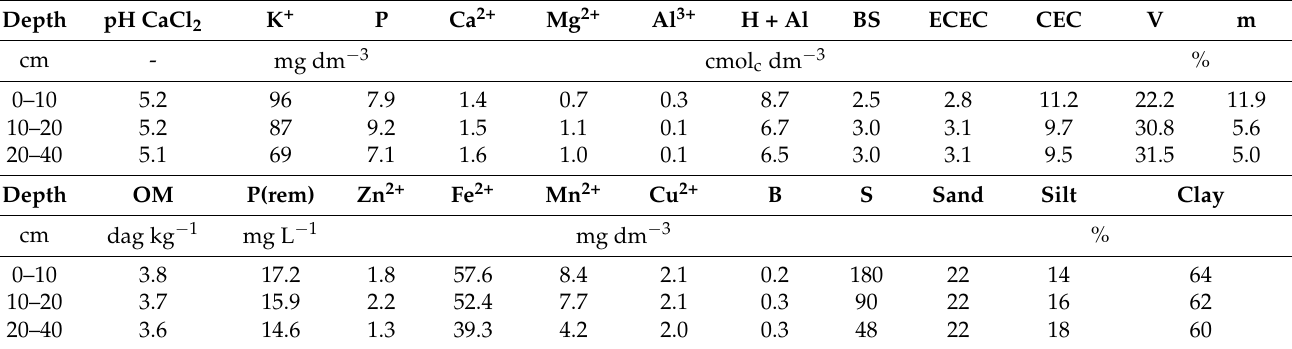
Table 4. Soil analyses results on September 2017.